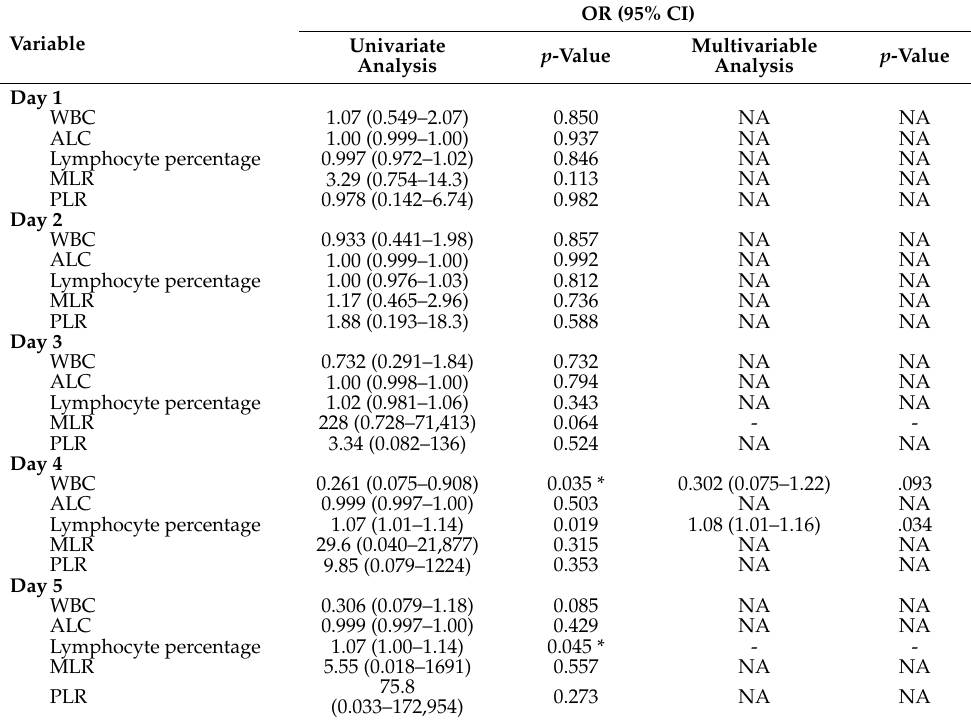
Table 4. Univariate and multivariate analysis of different measures and ratios in predicting the absolute neutrophil count difference (admission as a